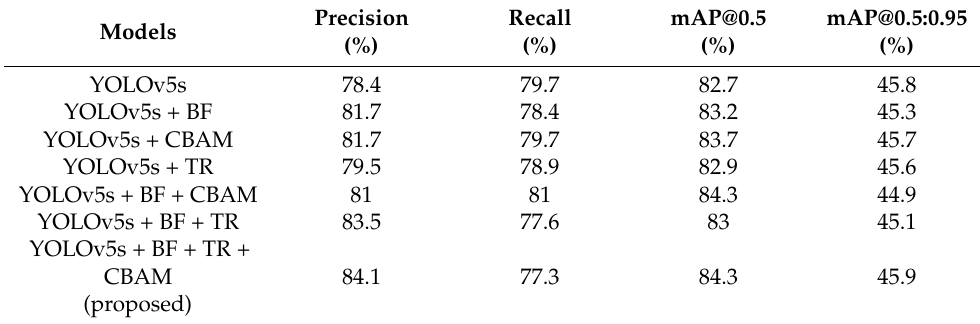
Table 4. Results of ablation experiments.